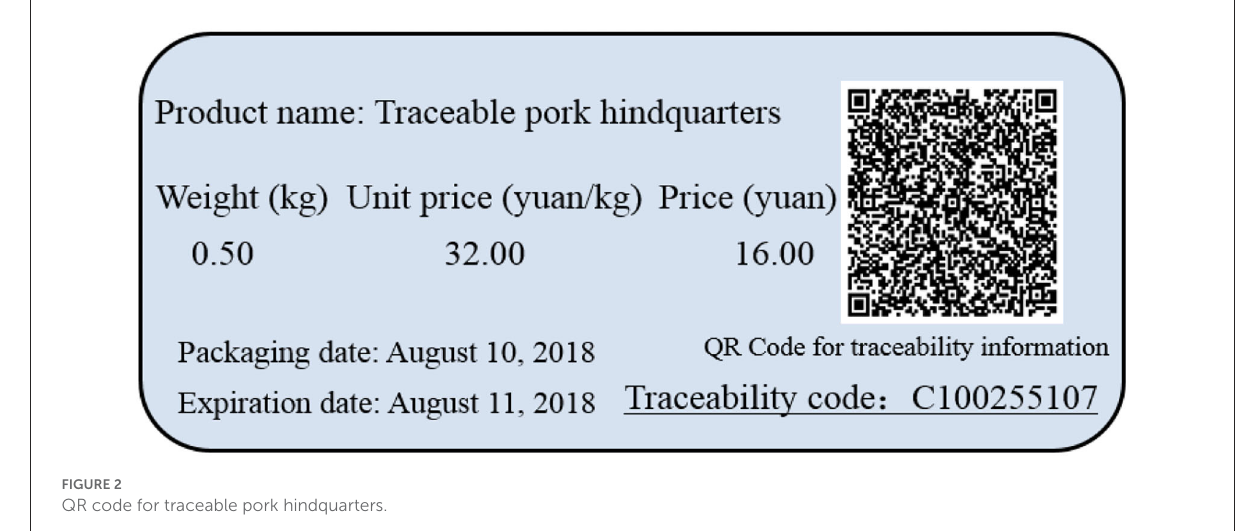
FIGURE2 QR code for traceable pork